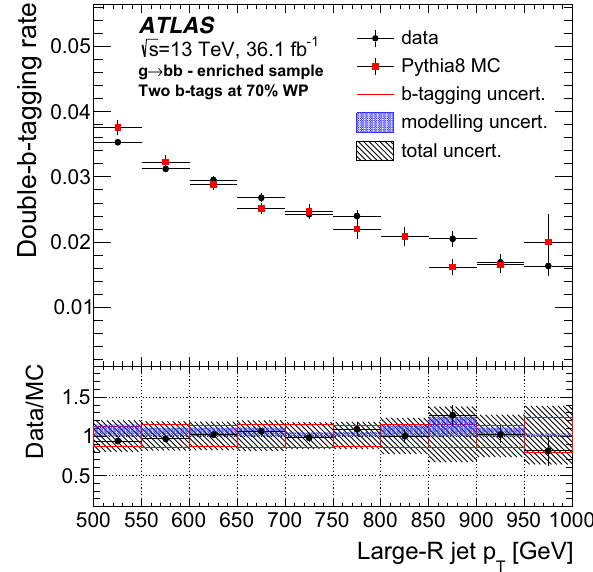
Fig. 16 ComparisonofdataandMCsimulationdouble- b -taggingrates as a function of the large- R jet p T . The flavour-tagging correction fac- tors and the flavour-fit corrections have been applied. The two largest systematic uncertainties, generator modelling and the b -tagging-related uncertainties, are shown as well. The total uncertainty includes all sys- tematic uncertainties listed in Sect. 5 and the fit uncertainty summed in quadrature. The size of the flavour-fit uncertainty is below